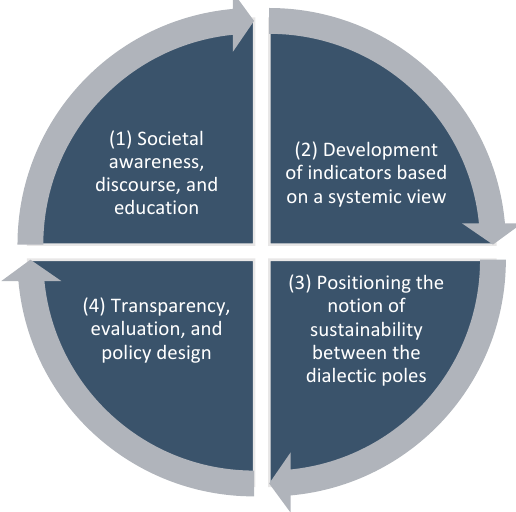
Figure 4. Circular model outlining the suggested procedure for a more differentiated look at the measurement of sustainability in the healthcare system (own illustration).